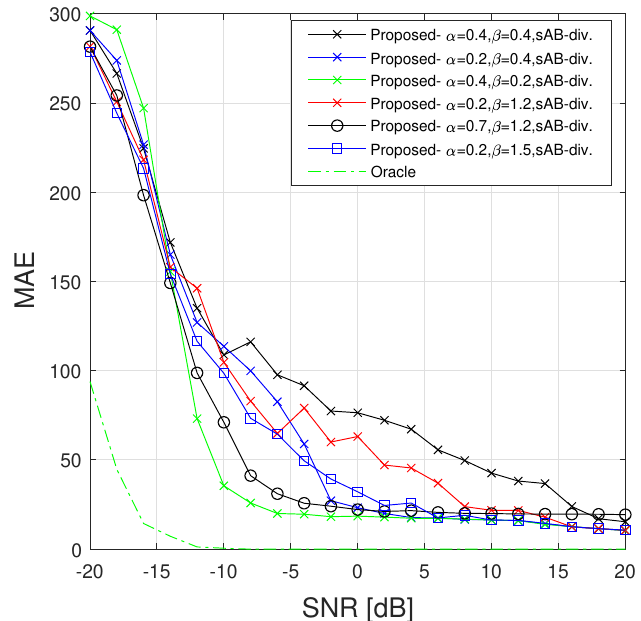
Figure 9. MAE between estimated detection array and ground truth for a linear chirp (truncated middle component in Figure 4) by using L = 20 (obtained with 100 realizations of